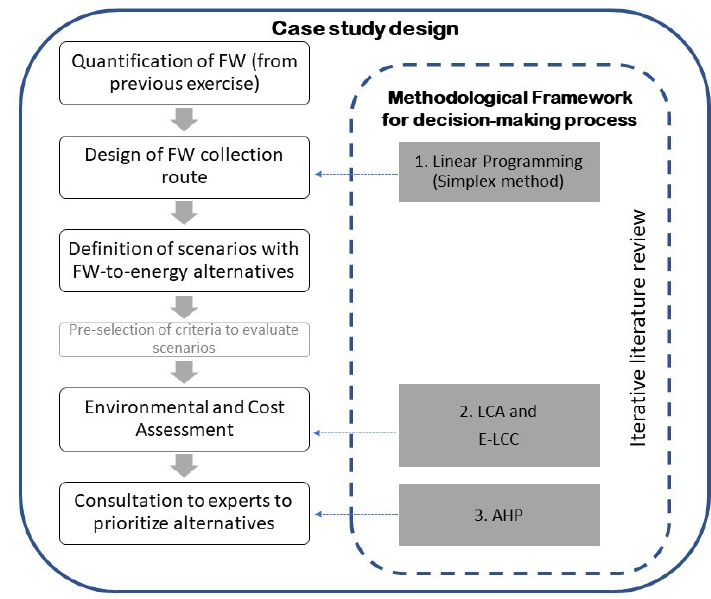
Figure 2. Methodological framework for a decision-making process of food waste (FW) valorization alternatives.